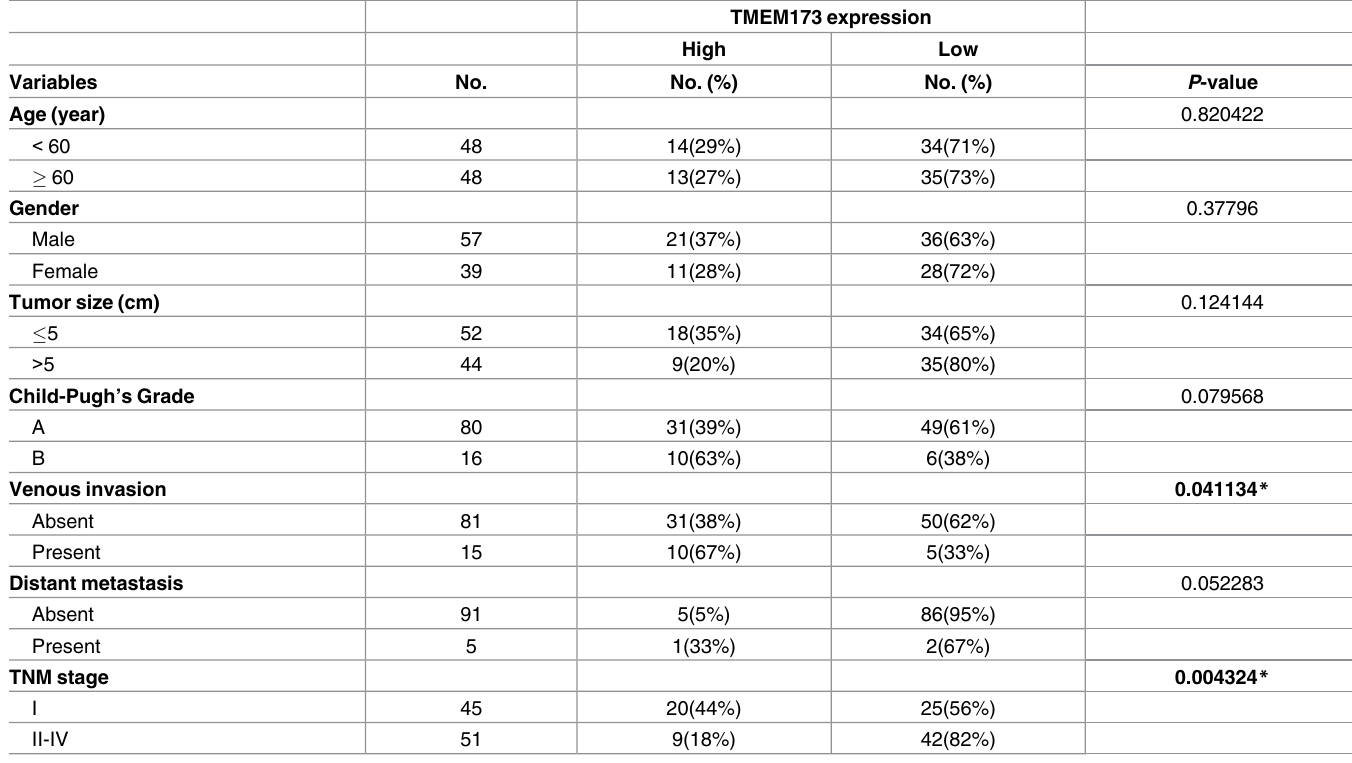
Table 1. Relationship between TMEM173 expression and clinicopathological characteristics in patients with